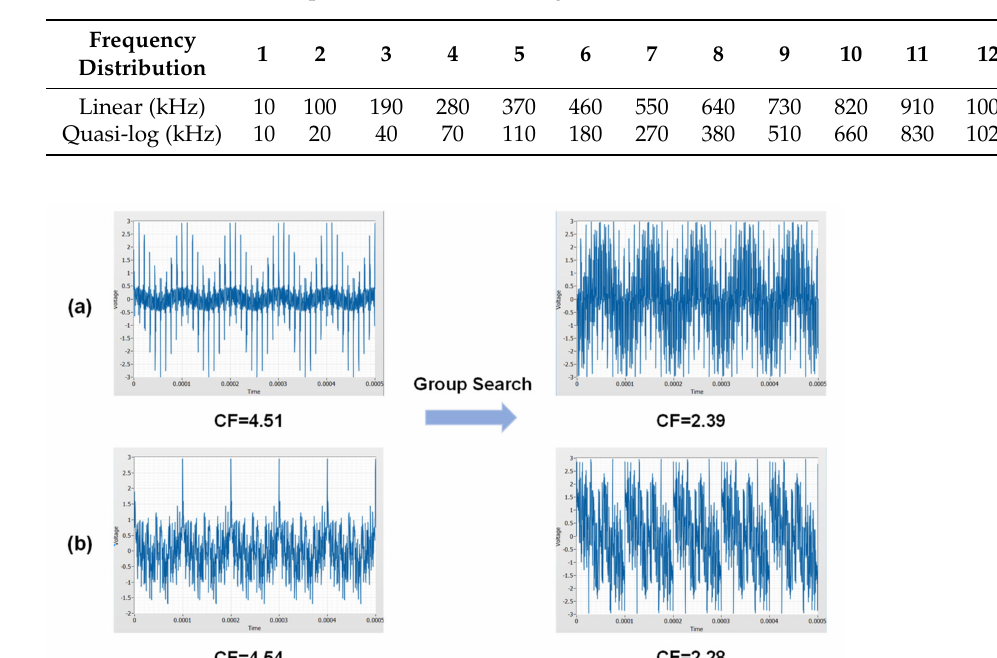
Figure 3. The time domain waveform and its crest factors (CF) of the multitone before and after group search algorithm. ( a ) denotes linearly distributed multitone and ( b ) denotes quasi-logarithmically distributed